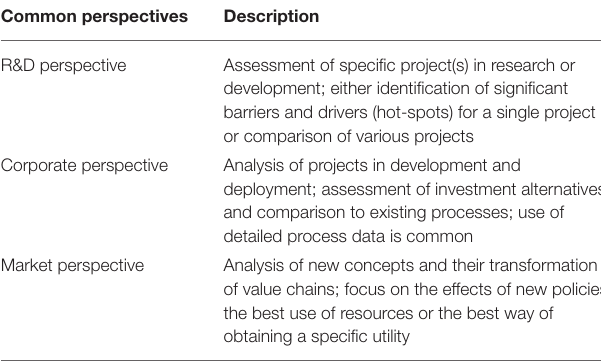
TABLE 1 | Common TEA